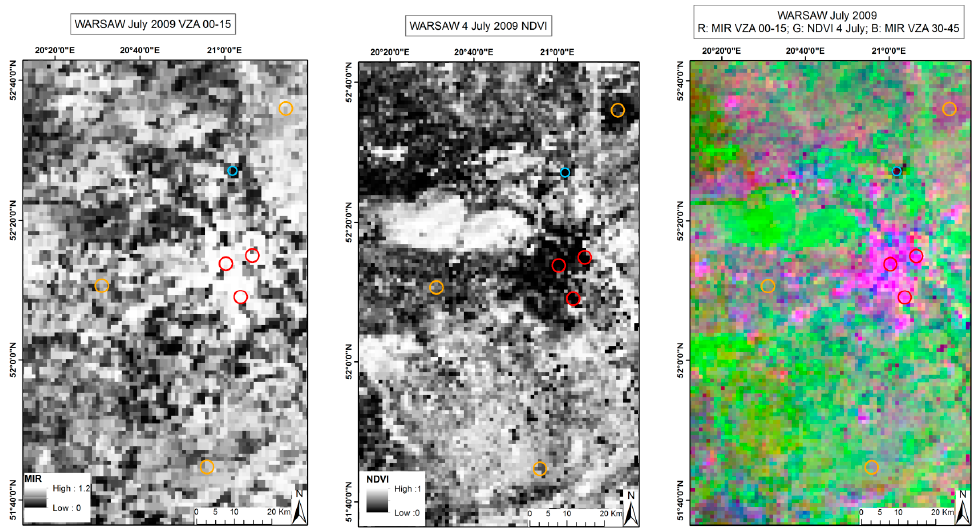
Figure 5. Image of Warsaw with samples of land cover classes: orange—croplands, red—urban, blue—water. Images are: July 2009 MIR composite at a view zenith angle (VZA) class of 0°–15° ( left ); NDVI July 2009 ( middle ); and False color composite for July 2009 R: MIR VZA 0°–15°, G: NDVI, B: MIR VZA 30°–45° ( right ).